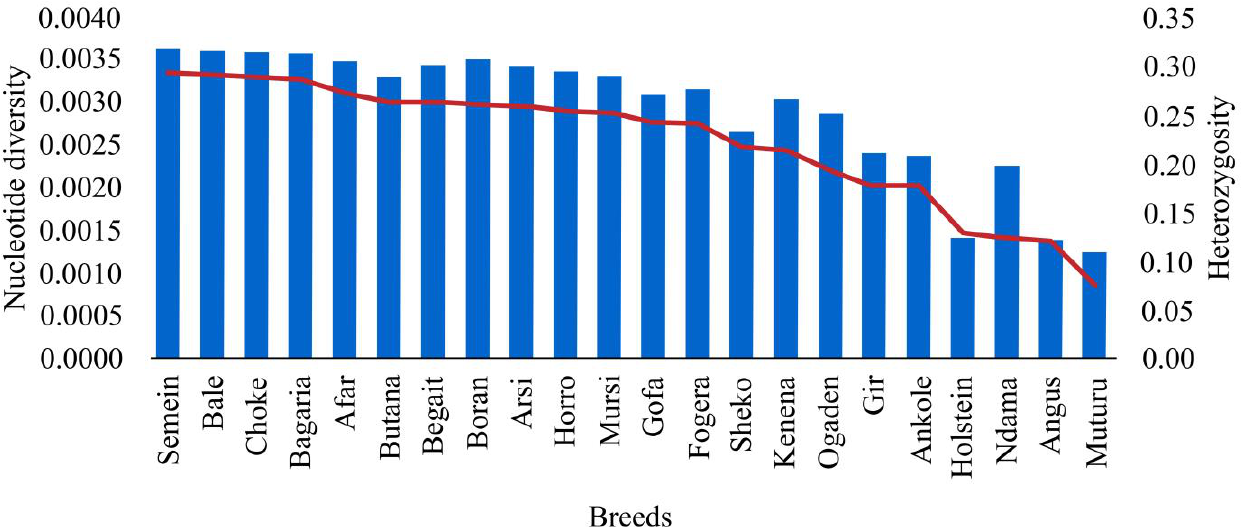
non-Ethiopian cattle